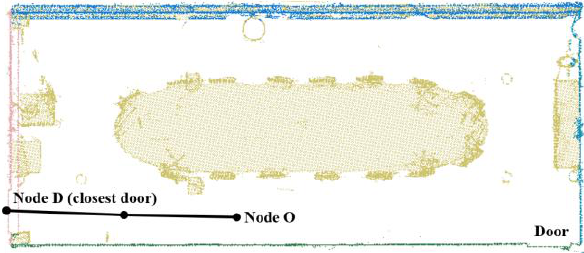
Figure 12: The shortest path for Route C is represented in